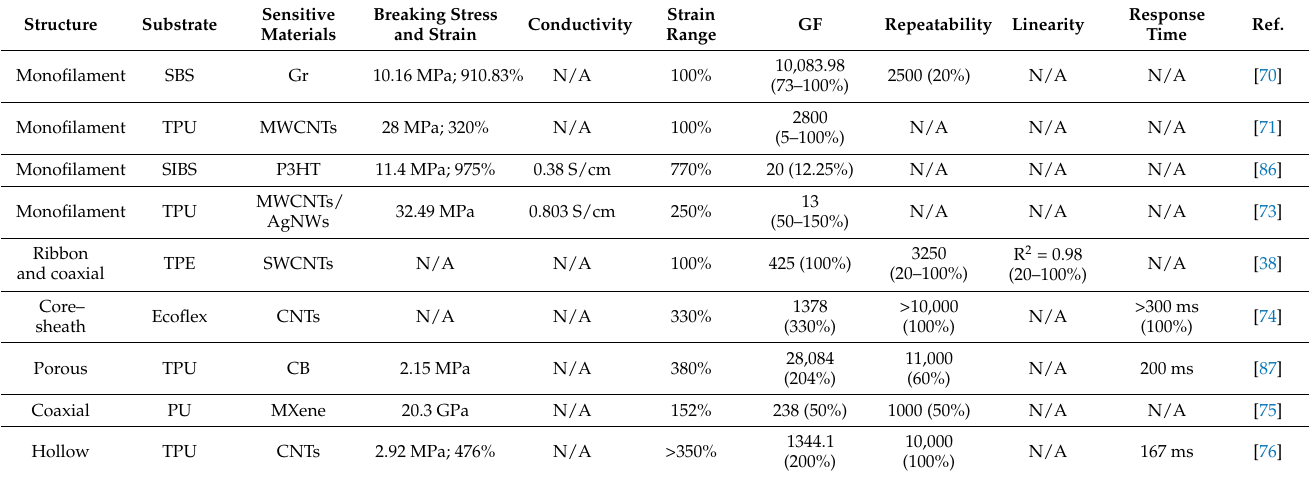
Table 4. Characteristics of conductive composite fiber-based strain sensors prepared by spinning